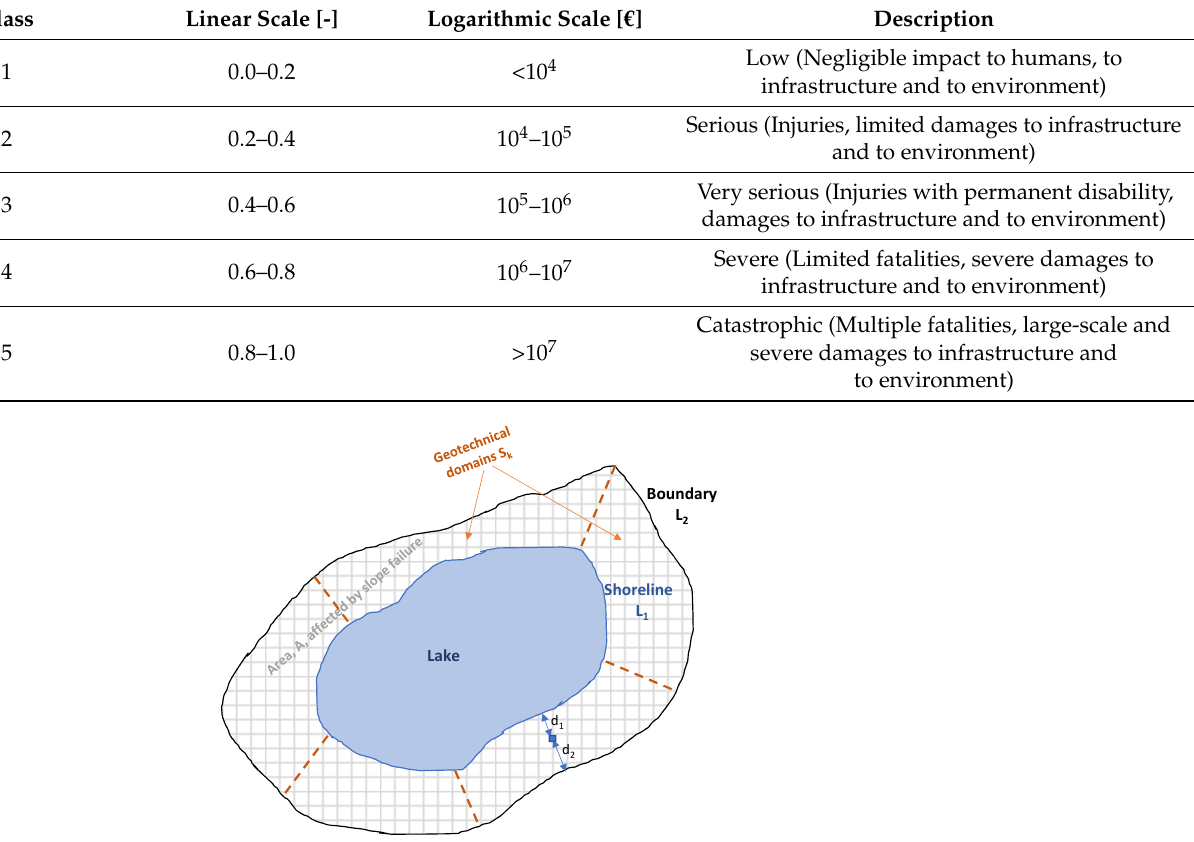
Figure 2. Boundaries, geotechnical domains and discretization of pit lake and affected area.